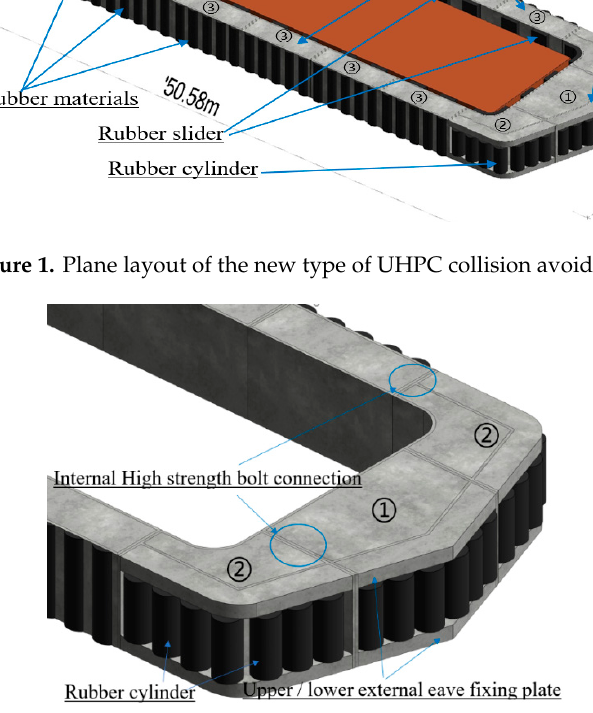
Figure 1. Plane layout of the new type of UHPC collision avoidance.